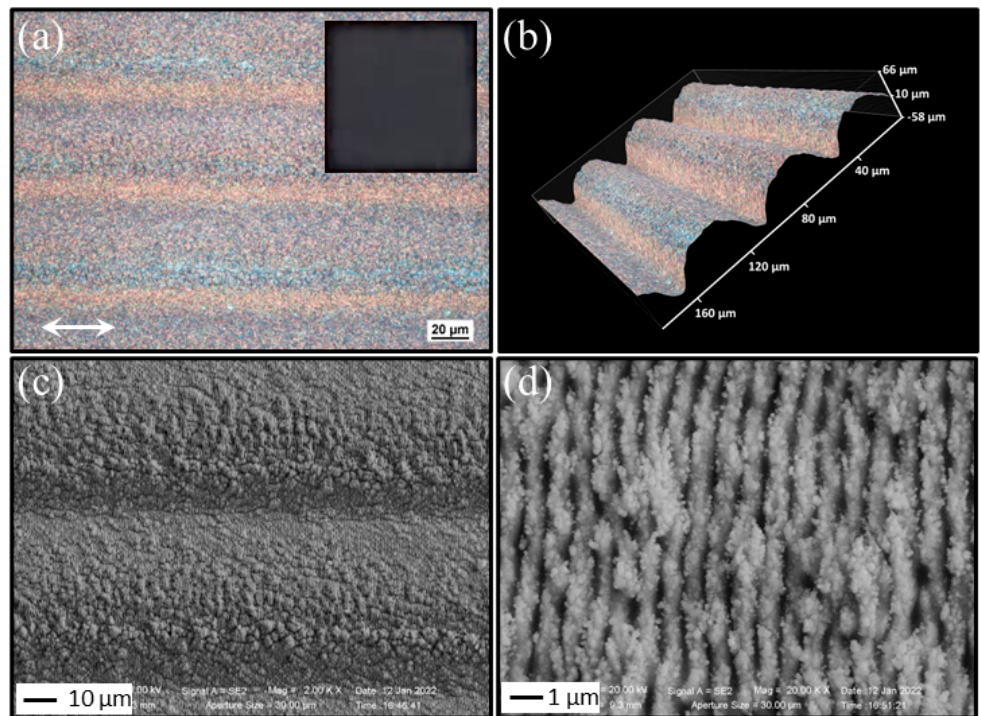
Figure 1. Exemplificative optical microscope and SEM images of the processed copper surface. The images refer to a sample processed with the spherical lens at 1030 nm at a repetition rate f p = 20 kHz and a scanning speed u s = 1 mm/s. The pulse energy is E ≈ 70 µ J and the corresponding peak fluence is F p ≈ 0.75 J/cm 2 . The hatch distance is ∆ y = 55 µ m. Panel ( a ) shows a microscope image. Here, the scanning direction is set along the polarization direction of the beam identified by the double headed arrow. A photograph of the processed sample of size 8 mm × 8 mm is given in the inset of panel ( a ). Panel ( b ) reports a 3D image of the processed area evidencing the formation of channels along the scan direction. Panels ( c , d ) report SEM images of the processed surface addressing the generation of subwavelength ripples and the surface decoration with nanoparticles.